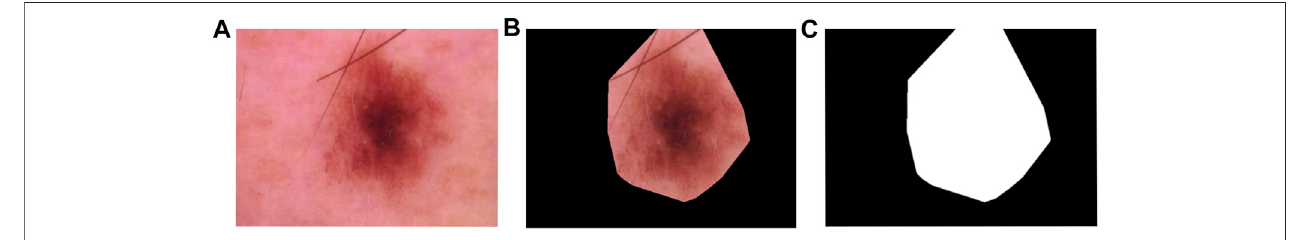
FIGURE 9 | (A) Example of skin lesion in HAM10000 (B) Skin lesion with mask (C) Mask only dataset.